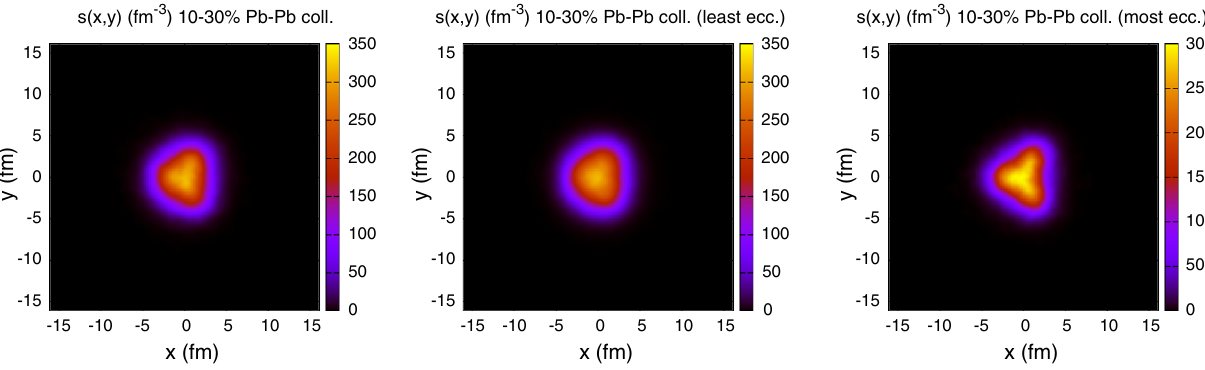
Fig. 4 The initial entropy-density for the 10–30% most central Pb–Pb collisions at cut (left), the 60% of events with the lowest triangular deformation (cid:7) 3 (middle) and the 20% of events with the highest (cid:7) 3 (right)